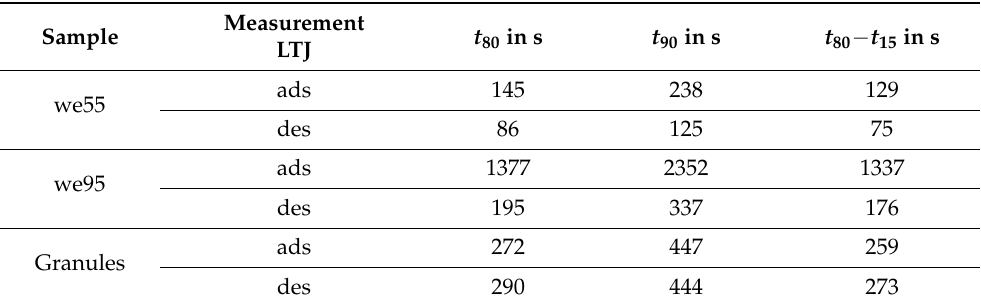
Table 8. Main dynamic quantities of the LTJ measurements on samples “we55”, “we95”, and “Granules” according to Sapienza et al. [53] t 80 , ( t 90 ): time when 80% (90%) of the equilibrium loading is reached, t 80 - t 15 : time span between 15% and 80% equilibrium